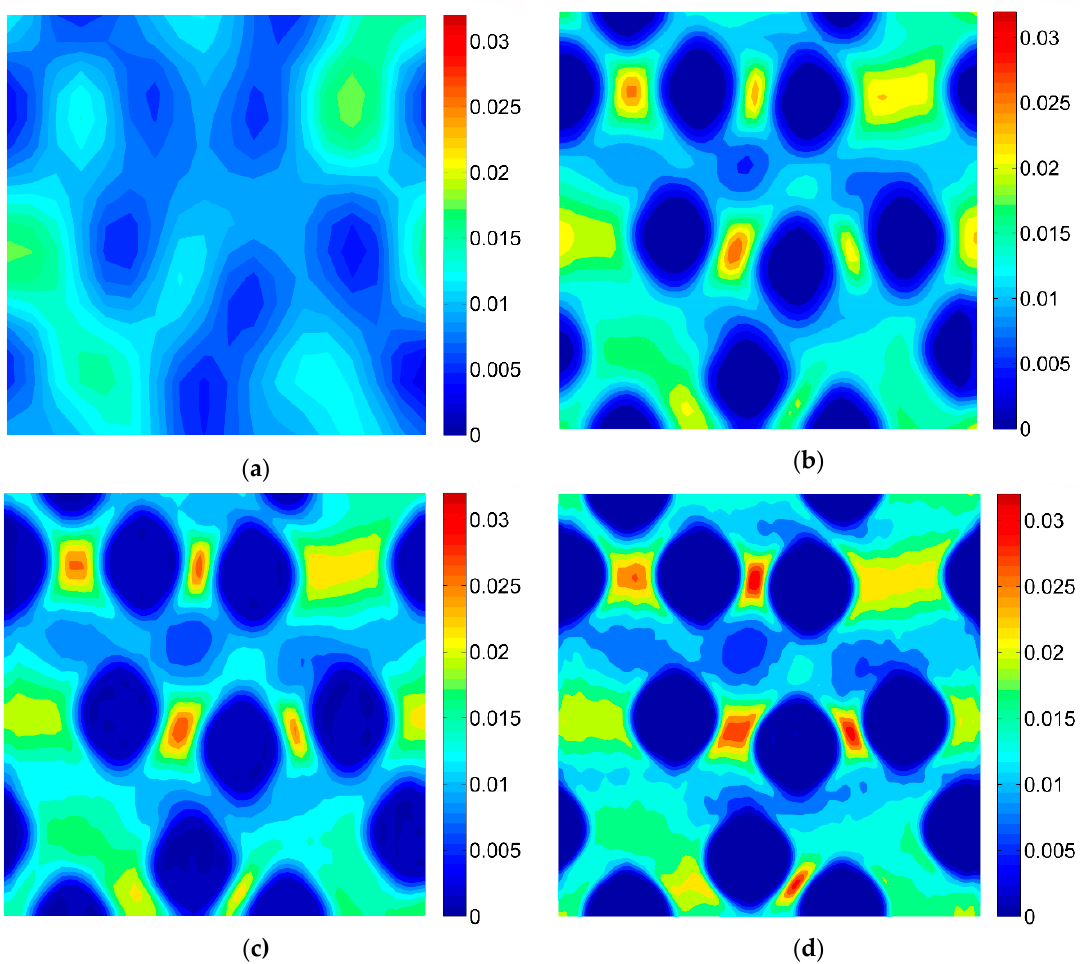
Figure 10. Distribution of strain ε 11 obtained for Material 1 with consideration of different speckle sizes, grid of squares: ( a ) 50 × 50, ( b ) 100 × 100, ( c ) 150 × 150, ( d ) 200 × 200.